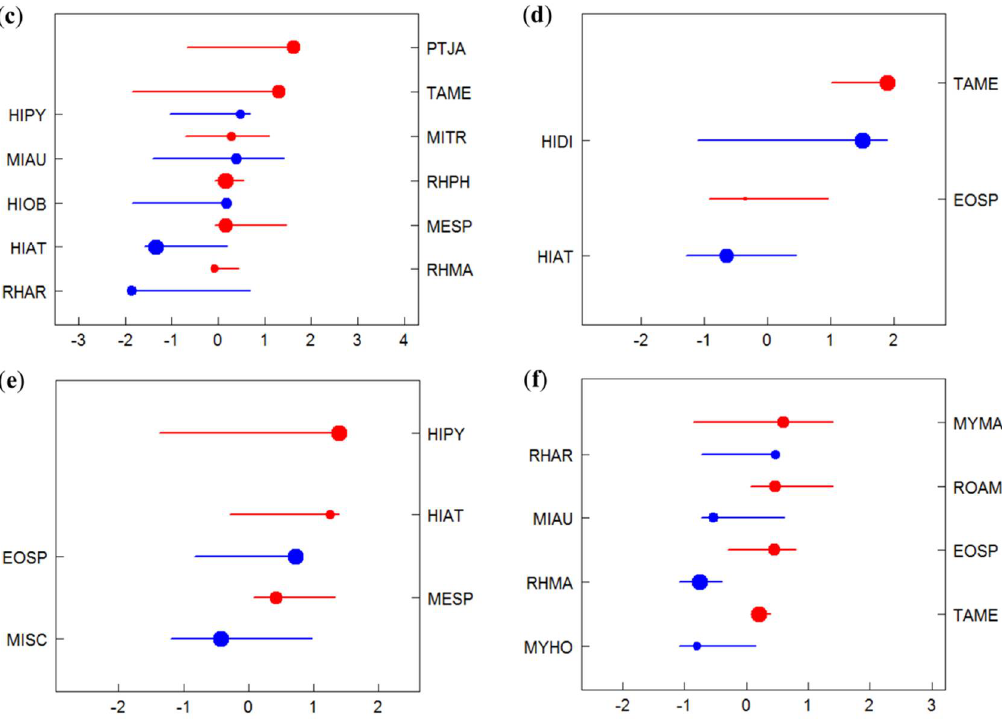
Figure 3. Species-specific change-points along environmental and human disturbance gradients. Species that exhibited a significant response ( p < 0.05) to a respective gradient are shown: ( a ) landscape disturbance, ( b ) cave complexity, ( c ) mining, ( d ) cave development, ( e ) resource extraction, and ( f ) bat hunting, with each species’ corresponding threshold represented by circles. Blue circles represent ‘losing’ species (z − ) with corresponding species labels on the left axes (see Table S2 for details) and red circles correspond to ‘winning’ species (z+) with corresponding species labels on the right axes. Circles are sized in proportion to the magnitude of each species’ response (based on z-scores), with overlapping horizontal lines representing the 95% confidence limits after 500 replicates. Species are ordered by increasing taxon-specific change-points along gradients, and alternate in order between ‘winners’ and ‘losers’.